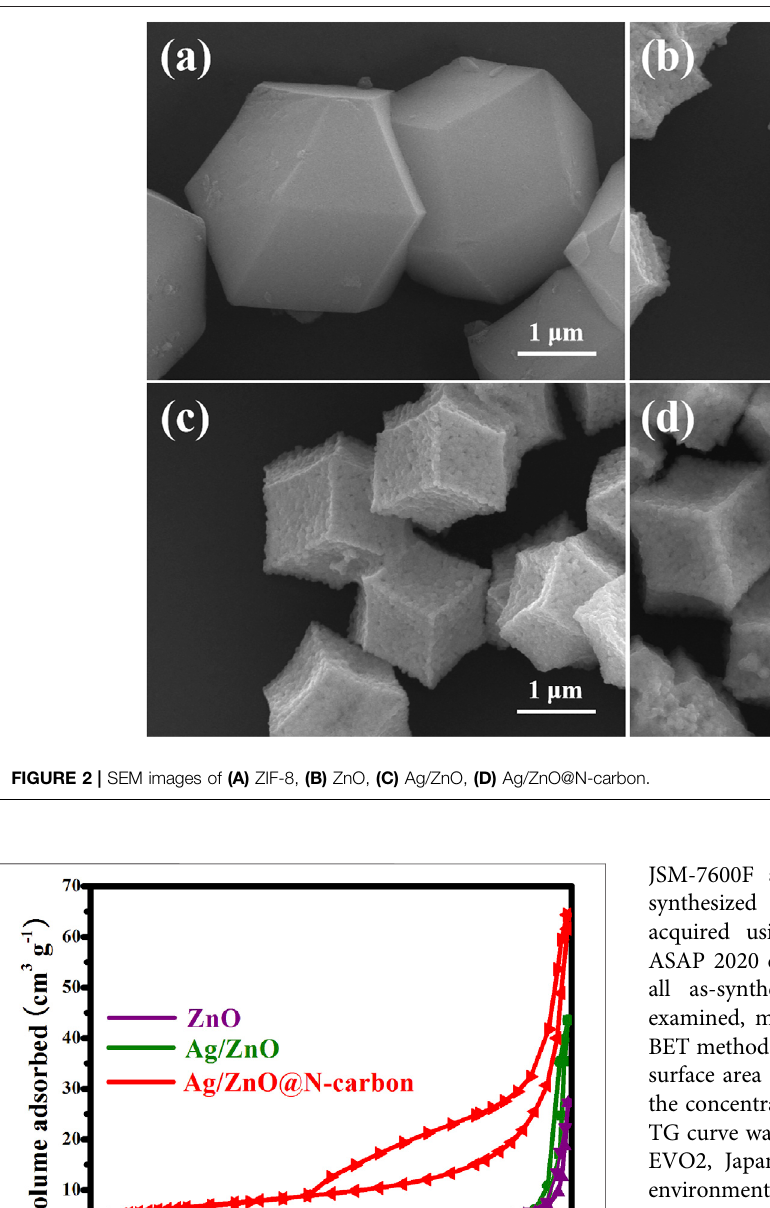
Frontiers in Chemistry |